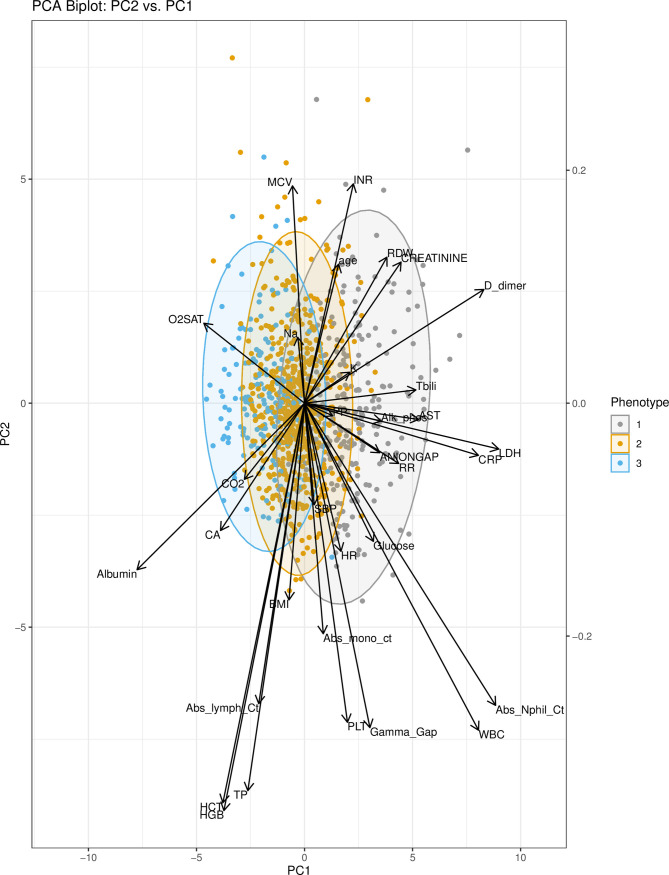
PCA biplot: PC2 vs. PC1.The scores (points) and loadings (arrows) of PC1 and PC2 are plotted for each patient and variable in the model. 95% confidence ellipses for the scores are shown. The biplot facilitates interpretation of the scores and loadings, assigning context to the variables which prominently contribute to the phenotypes. Abbreviations: PC1 (principal component 1); PC2 (principal component 2); PCA (principal component analysis); Abs_Nphil_Ct (absolute neutrophil count); LDH (lactate dehydrogenase); CRP (C-reactive protein); WBC (white blood cell count); HCT (hematocrit); HGB (hemoglobin); Tbili (total bilirubin); RDW (red cell distribution width); AST (aspartate aminotransferase); Alk_phos (alkaline phosphatase); RR (respiratory rate); CA (calcium); TP (total protein); INR (internal normalized ratio of prothrombin time); CO2 (carbon dioxide); K (potassium); O2SAT (oxygen saturation); BMI (body mass index); PLT (platelet); PP (pulse pressure); Na (sodium); SBP (systolic blood pressure); Abs_mono_ct (absolute monocyte count); MCV (mean corpuscular volume).